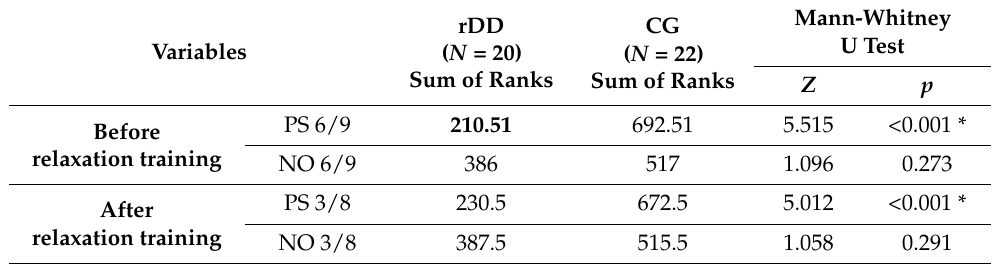
Table 2. Comparison of the results of the two versions of the APT test in the study groups ( N = 42). Mann-Whitney rDD CG Variables ( N = 20) ( N = 22) Sum of Ranks Sum of Ranks Z p PS